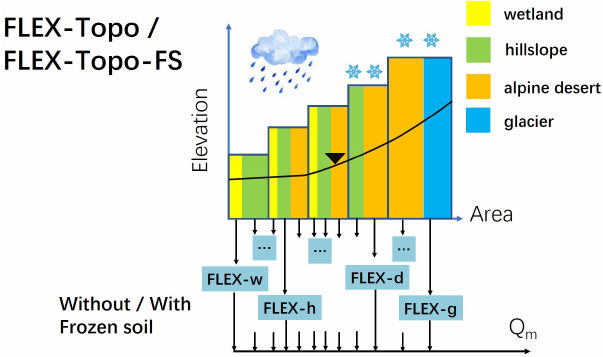
Figure 8. Model structures of FLEX-Topo and FLEX-Topo-FS. FLEX-w means the module for wetland, FLEX-h for hillslope, FLEX-d for alpine desert, and FLEX-g for glacier,